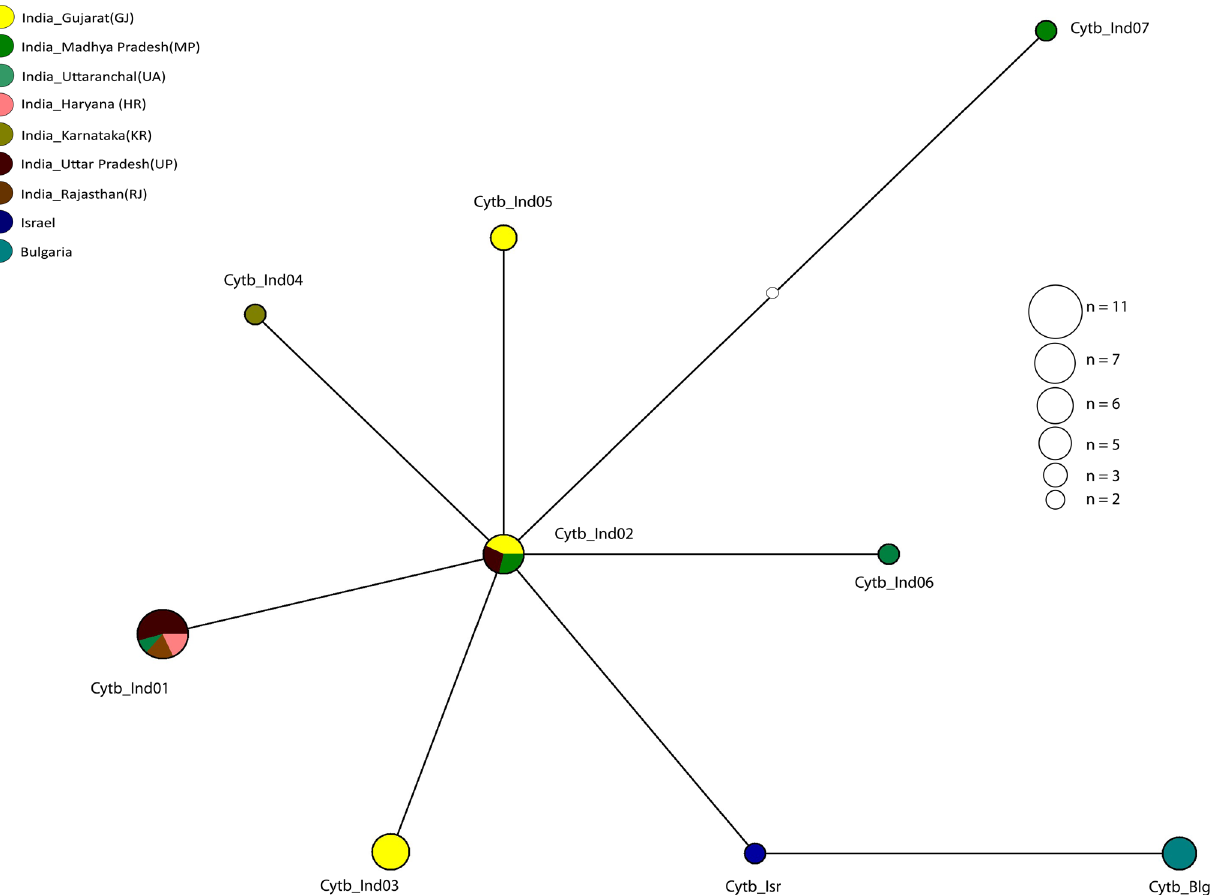
Fig 3. Median joining mtDNA cyt b (390 bp) haplotype network tree, showing star-like radiation and polytomy of golden jackal haplotypes. Haplotype circles are colour coded according to geographic locality, and circle size is proportional to haplotype frequency. Each node represents a one base pair change. See Table 1 for variable nucleotide positions used in network construction. Circle sizes are proportional to the number of individuals represented by each haplotype.